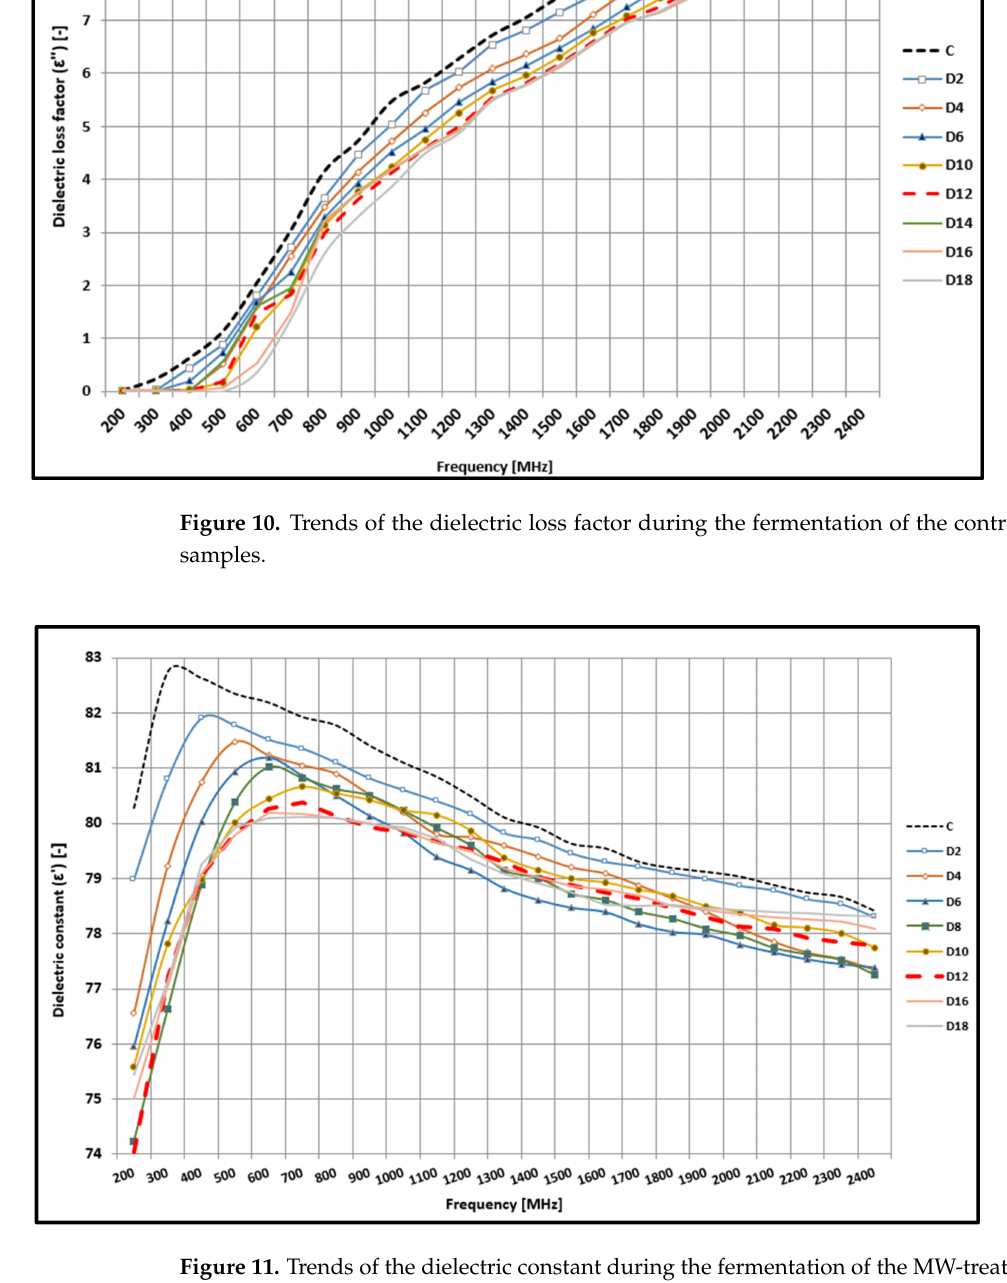
Figure 11. Trends of the dielectric constant during the fermentation of the MW-treated